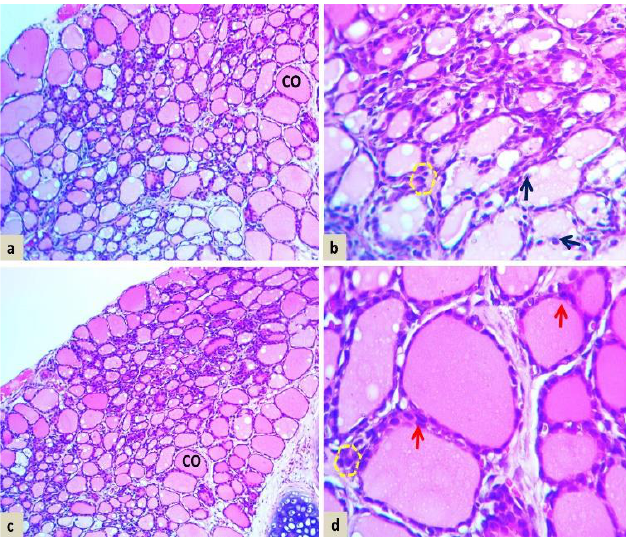
Figure 9. Microscopic photographs of seminiferous tubules sections in the diabetic male Wister rats treated with 500 mg/kg BW ( a and b ) and 1000 mg/kg BW ( c and d ) of Quercus infectoria galls (QIg) extract. a , Mild degeneration of follicular cells (black arrows) that contain a large amount of colloid (CO) (H&E, 100×); b , mild vacuolization of follicular cells (black arrows) and parafollicular cells (yellow polygonal) (H&E, 400×). c , Well organized thyroid follicles with normal colloidal content (CO) (H&E, 100×); d , normal height of follicular cells (red arrow) and intact parathyroid cells (yellow polygonal) (H&E, 400×)